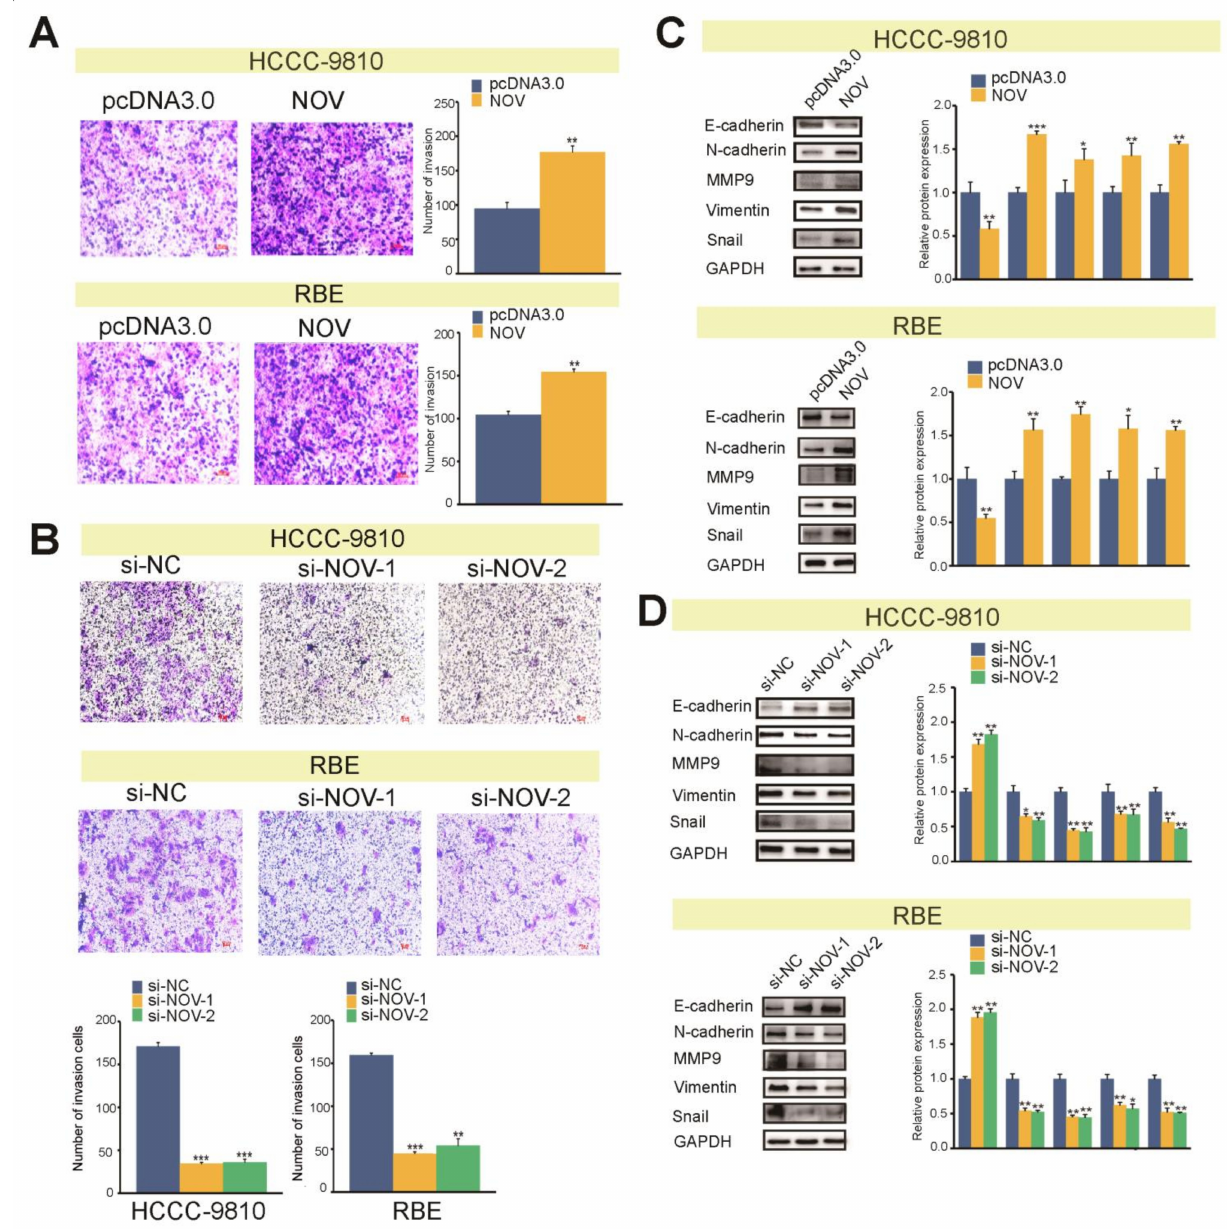
Figure 6. NOV promotes the invasion of ICC cells. ( A ) The effect of NOV overexpression on invasion ability (100 × ). ( B ) The effect of NOV silencing on invasion ability (100 × ). ( C ) The effect of NOV overexpression on EMT proteins confirmed by Western blot. ( D ) The effect of NOV silencing on EMT proteins confirmed by Western blot. All experiments are repeated three times independently, and the data are analyzed by t -test. * indicates p < 0.05, ** indicates p < 0.01 and *** indicates p <